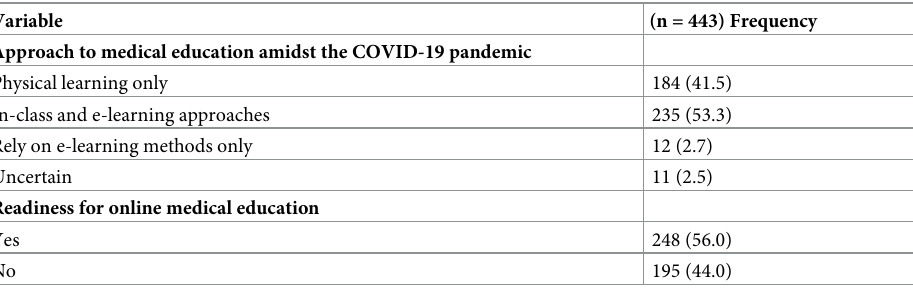
Table 6 shows predictors of readiness for online medical education. The predictors of readi- ness for online medical education included previous participation in a webinar, AOR = 2.1,